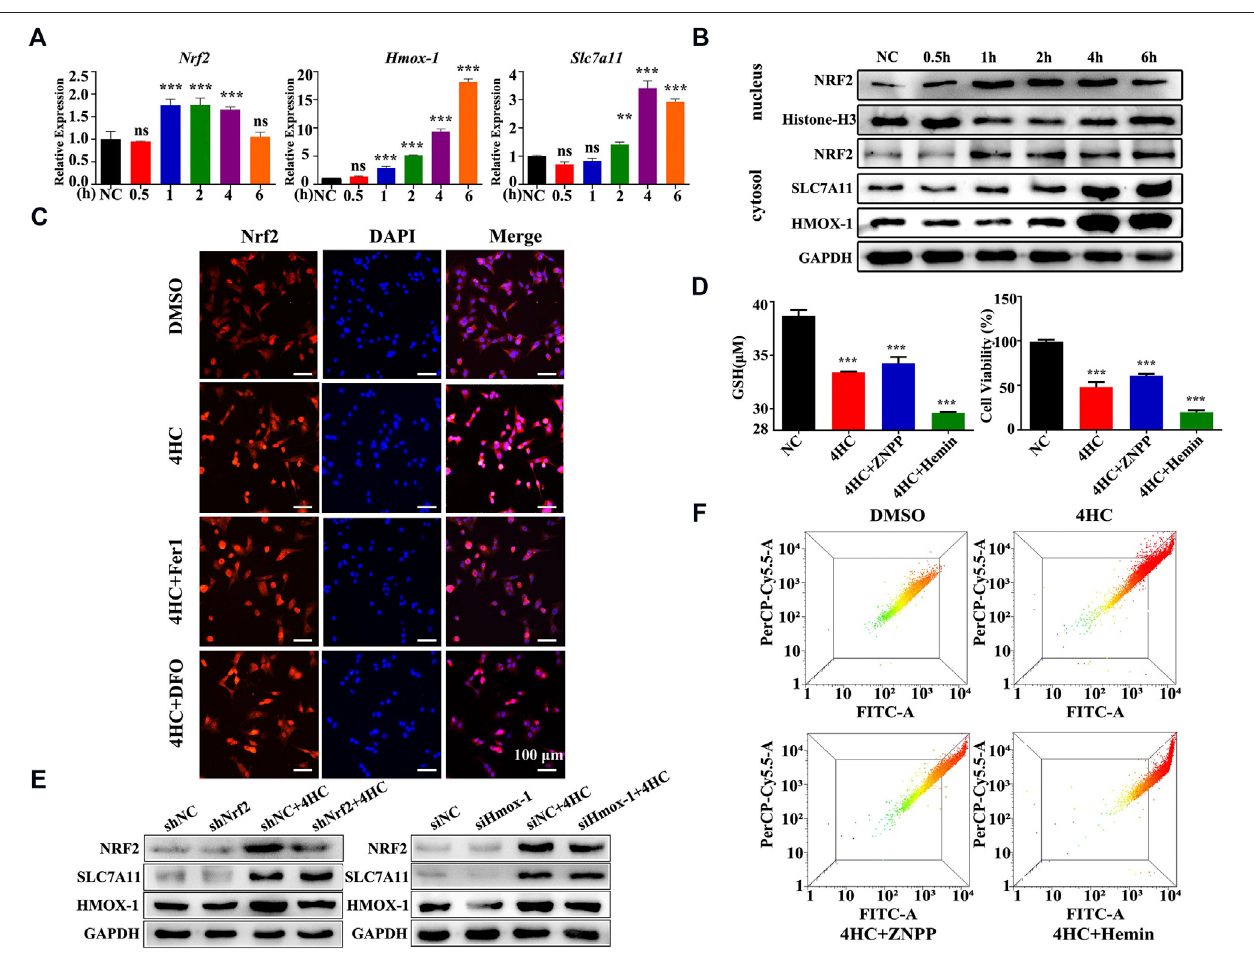
FIGURE6| TheNRF2/HMOX-1pathway playsaroleinCTX-inducedferroptosis. (A) RelativeNrf2,Hmox-1andSlc7a11mRNAlevelsin4T1celllines treatedwith 4HC(20 μ M)fortheindicatedtimes.Dataarerepresentedasthemeans±SDfromthreeindependentexperiments.ns,notsigni fi cant,** p < 0.01,and*** p < 0.001(one- way ANOVA analysis). (B) Western blot analysis of NRF2/HMOX-1 system expression in 4HC-treated cells. Histone H3 served as a loading control, and representative results from three experiments are shown. (C) Images of immuno fl uorescence staining for NRF2. Representative images from experiments with similar results are shown (scale bar = 100 μ m). (D) Intracellular GSH levels and the viability of cells after exposure to the speci fi c HMOX-1 inhibitor zinc protoporphyrin (ZNPP) and agonist Hemin. Values are presented as the means ± SD from more than three independent experiments. *** p < 0.001 (one-way ANOVA analysis). (E) Western blot analysis of NRF2, HMOX-1 and SLC7A11 levels in transfected cells. GAPDH served as a loading control, and representative results from three experiments are shown. (F) Flow cytometry analysis of the MMP in cells treated under the indicated conditions; representative results from three experiments are